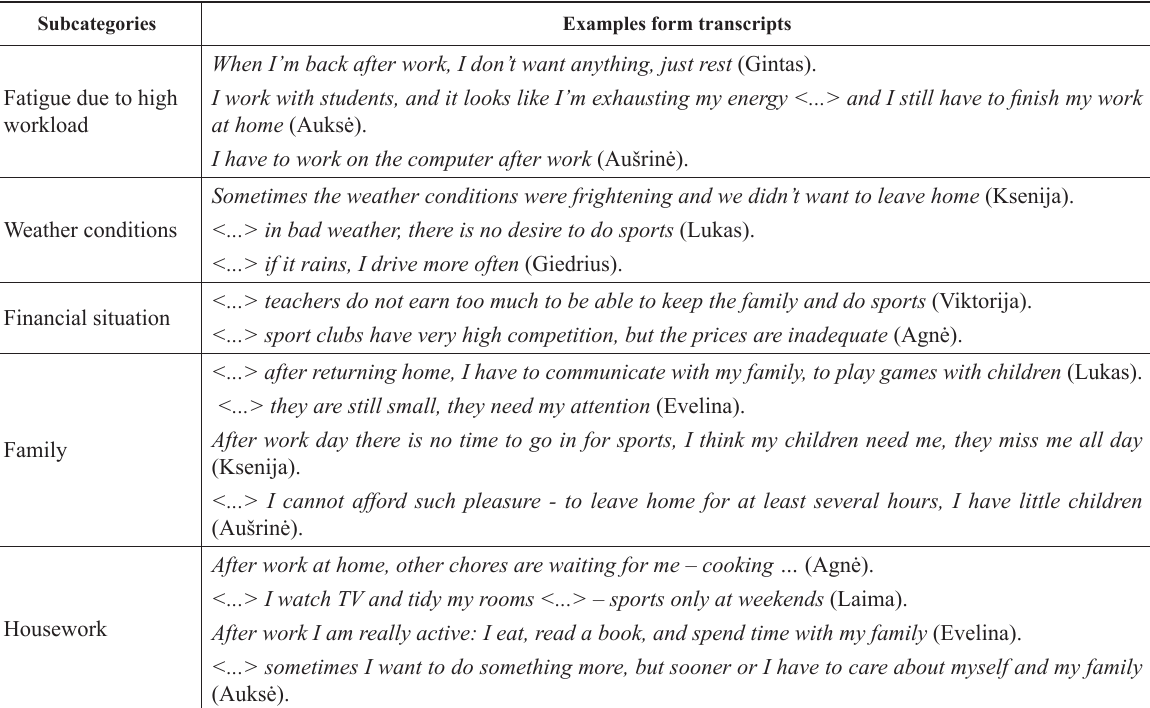
Table 7. External causes of physical inactivity Subcategories Examples form